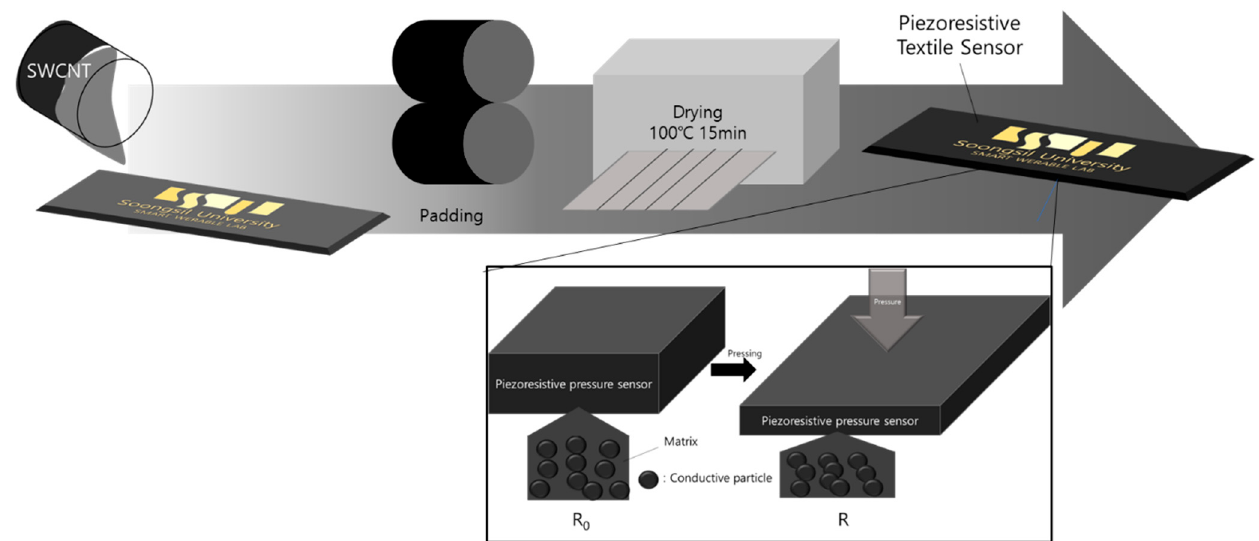
Figure 3. The fabrication process for dip coating of pressure-sensing layers.